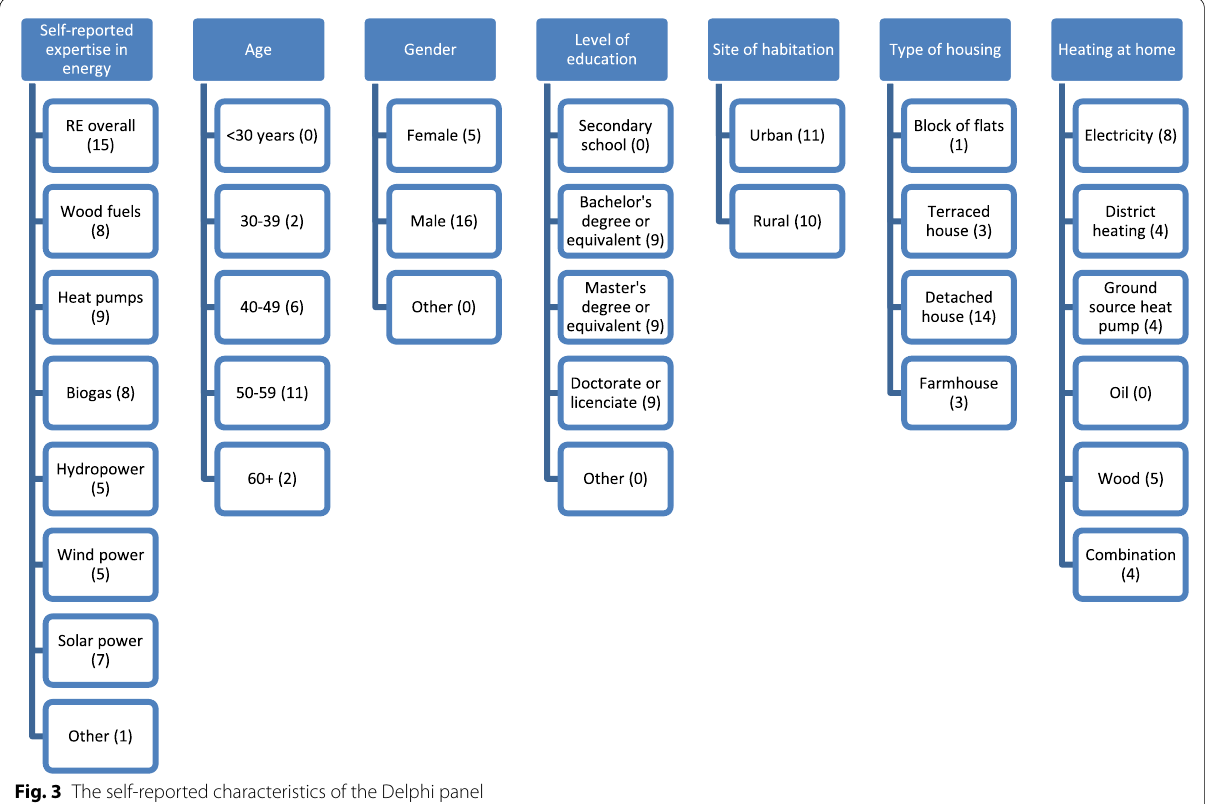
Fig. 3 The self-reported characteristics of the Delphi